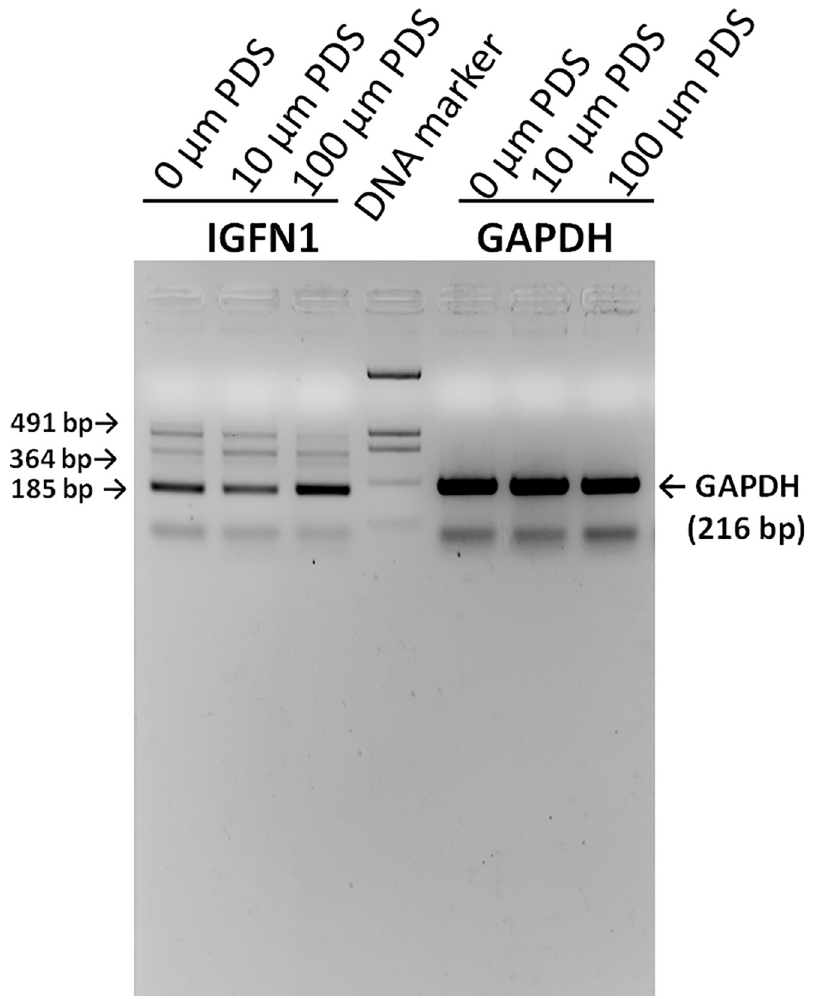
Fig 8. Role of PDS in splicing of IGFN1 intron 15. RT-PCR from the cDNA of UOK146 cell line after the treatment with 0, 10, 100 μ M PDS for 24